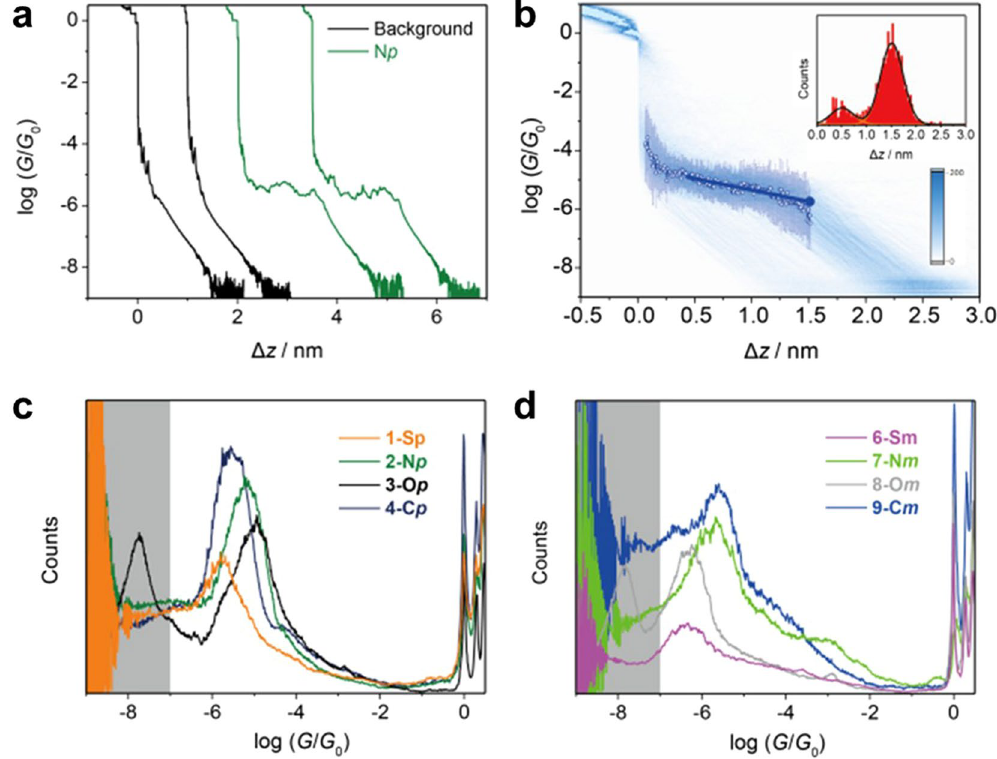
Figure 3. Single-molecule conductance results from MCBJ experiments. ( a ) Typical individual conductance– distance traces (horizontally offset for clarity) of N p (green) and pure tunneling traces (black). ( b ) All-data- point 2D conductance versus relative distance ( Δ z ) of N p . In 2D histogram, statistically averaged conductance– distance traces (hollow circles) with variations indicated by the standard deviations (bars) are shown, along with the linear fit (line). The solid circle represents the last data point in the linear fit before junction rupture. Inset: Stretching distance distribution obtained between 10 − 0.30 G 0 and 10 − 6.25 G 0 . ( c ) and ( d ) All-data-point 1D conductance histograms constructed from more than 1,000 MCBJ traces of molecules with anchoring groups on ( c ) para-para and ( d ) meta–meta position. The gray area represents the detection limit of the MCBJ set up at 10 − 7 G 0